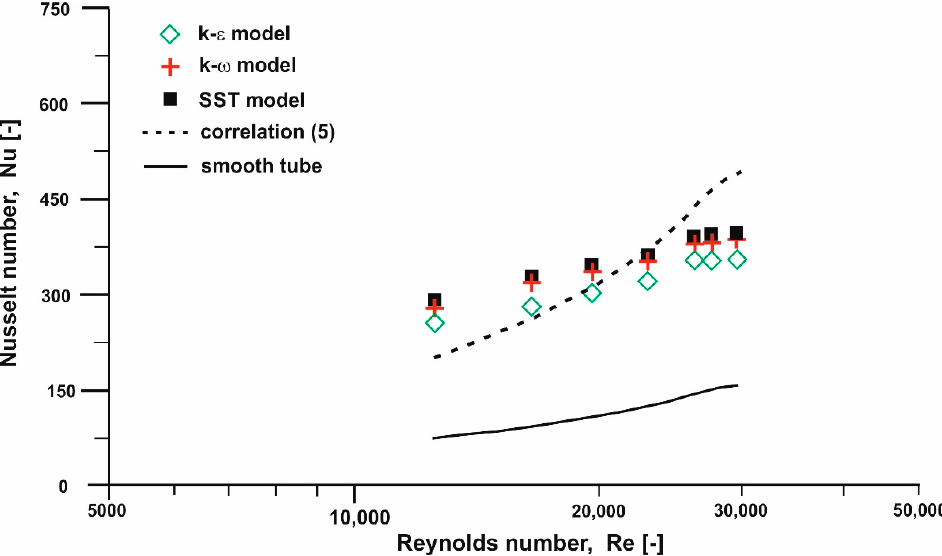
Figure 9. Comparison between Nusselt number values obtained from CFD modelling and correlation (5) for a tube with internal spiral ribs and for a smooth tube (heater power—8 kW).